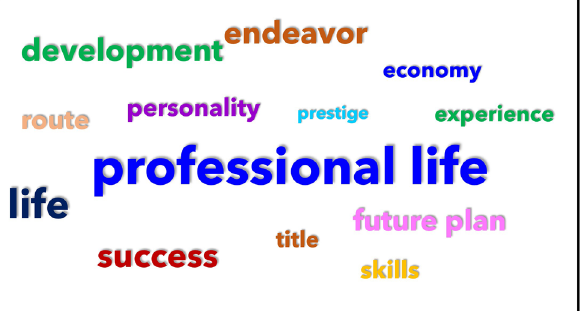
Figure 1: Word cloud of students ’ qualitative data on career